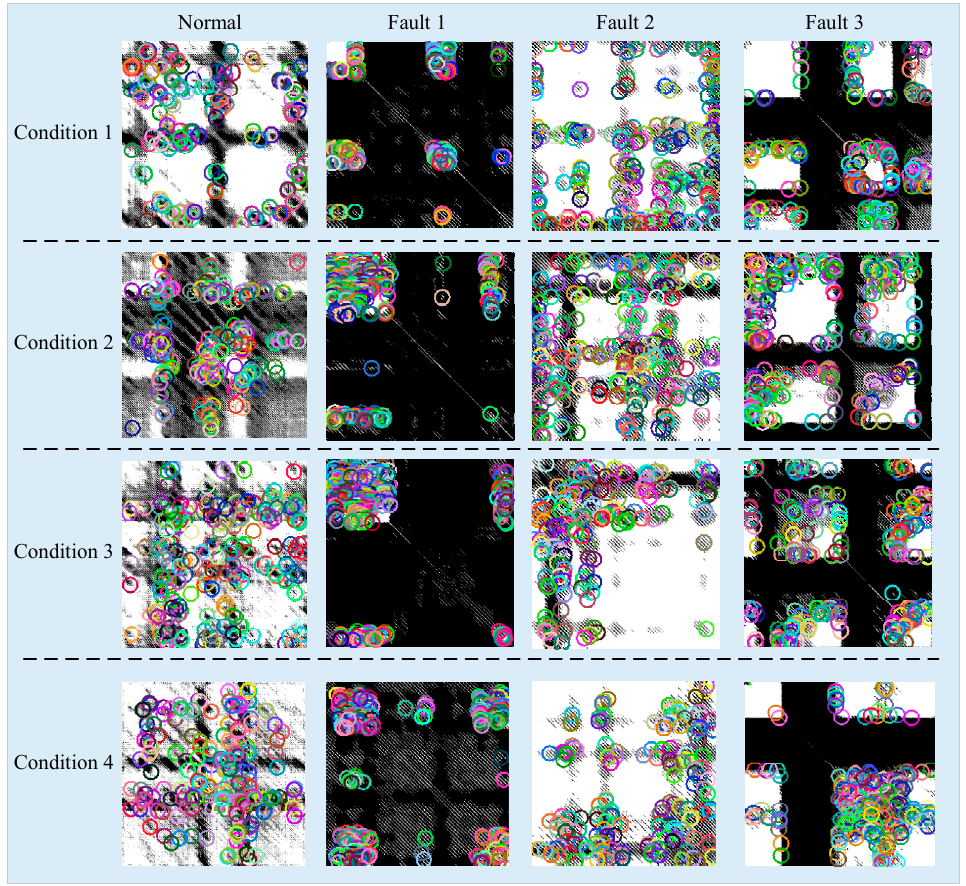
Figure 16. Detected interest points in RPs.